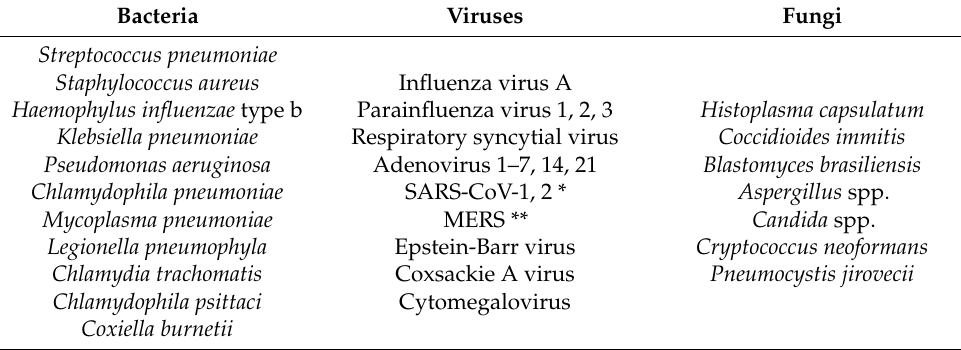
Table 1. The main etiological agents of